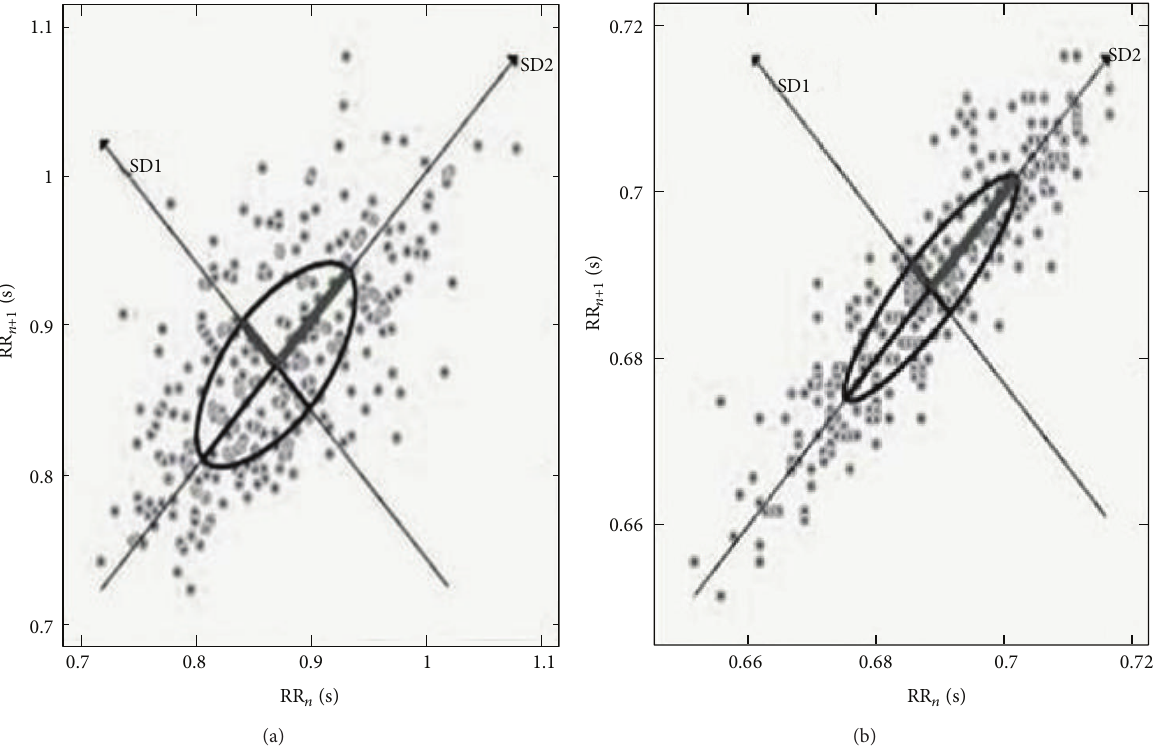
Figure 1: Visual differences in Poincare plot of two women at rest after posteroanterior glide technique mobilization. (a) Healthy woman and (b) woman with